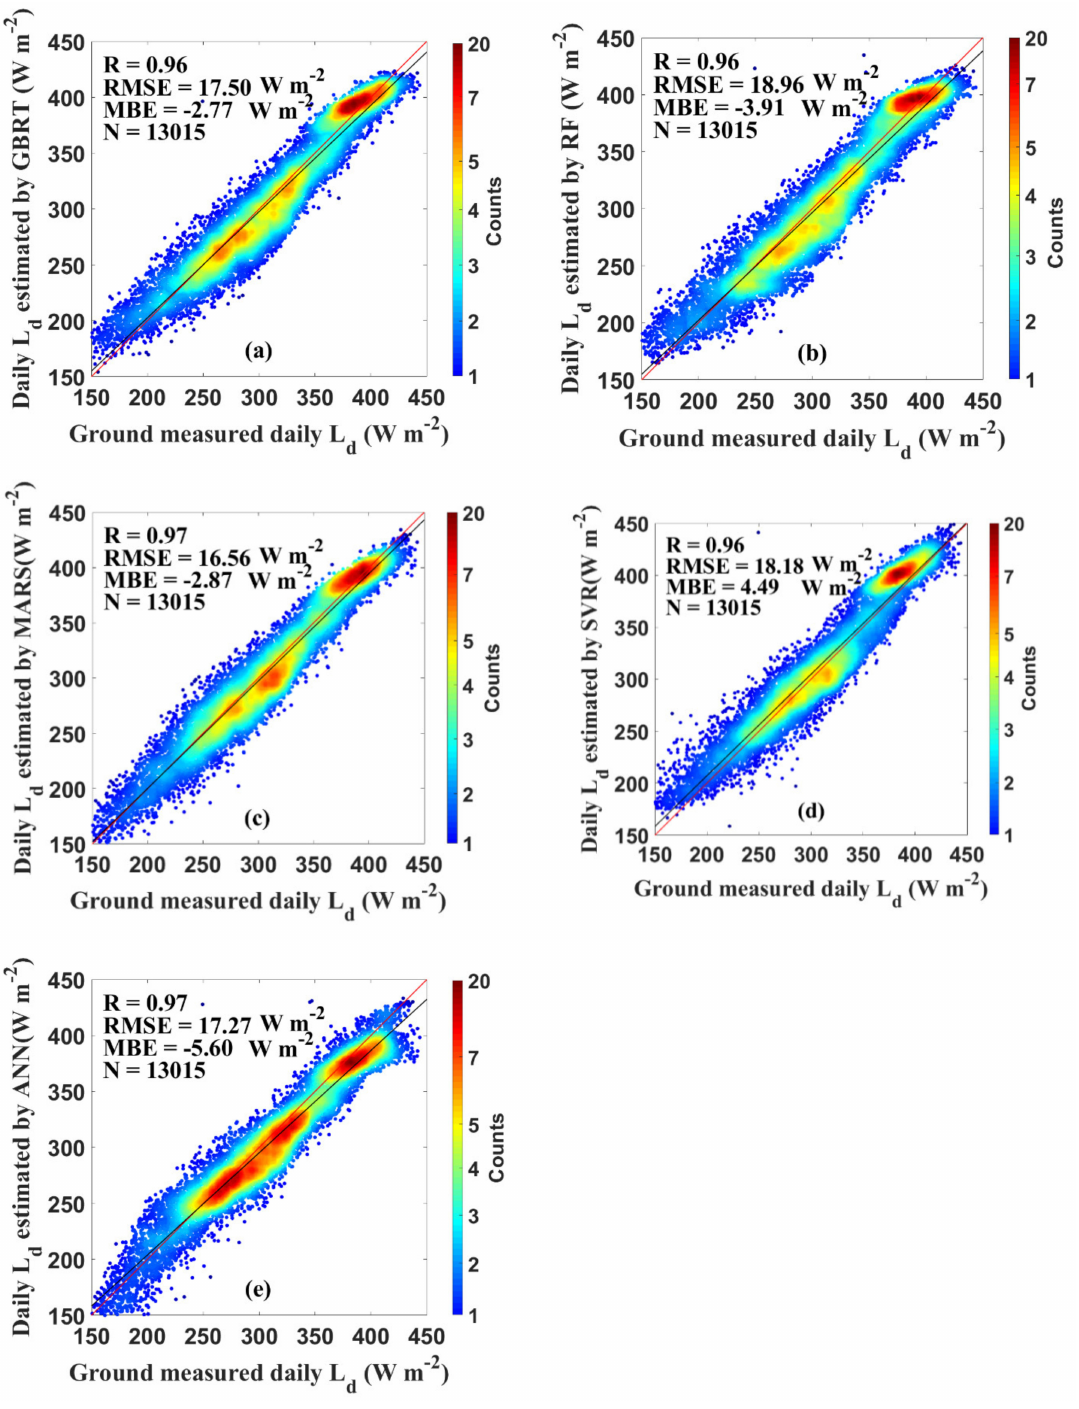
Figure 3. Evaluation results of the daily L d estimates on the basis of the ( a ) GBRT, ( b ) RF, ( c ) MARS, ( d ) SVR, and ( e ) ANN methods against the ground measurements on the test dataset. N is the number of data records. The red and black lines represent the 1:1 and fitted lines,